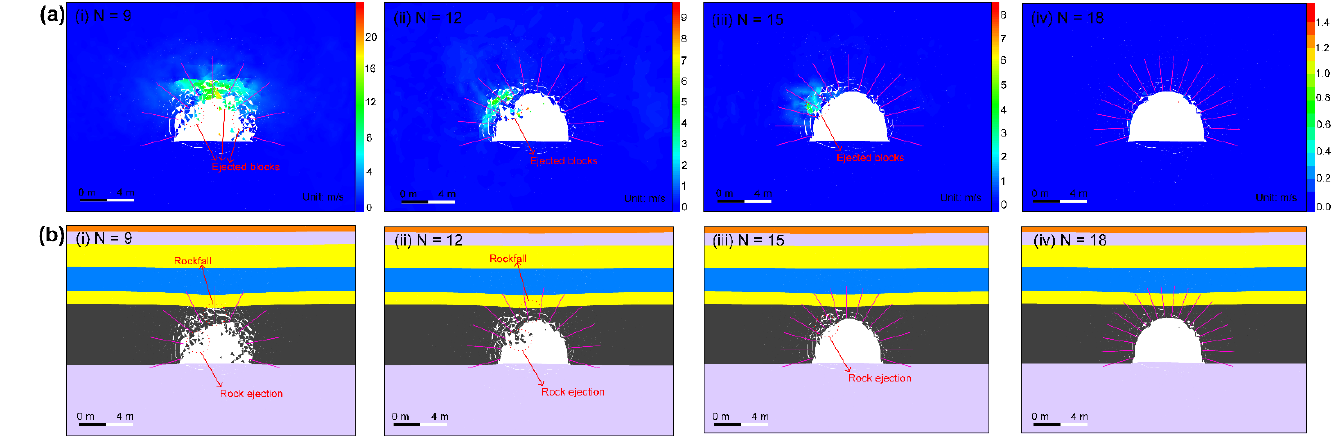
Figure 19. ( a , b ) are simulated velocity distribution and macroscopic failure patterns of the tunnel. N is the bolt number.